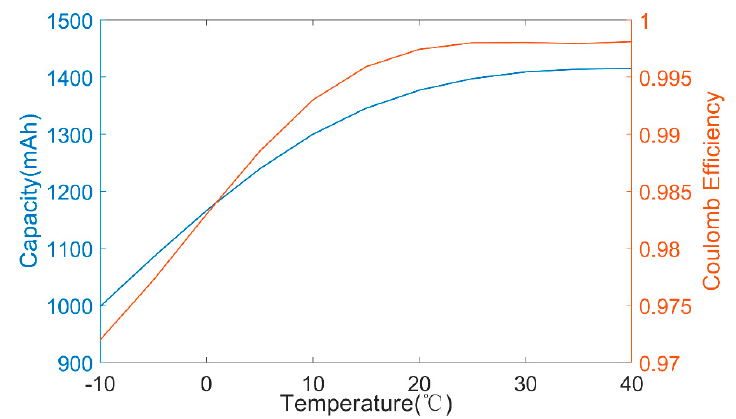
Figure 1. Battery capacity and coulombic efficiency at different temperatures.